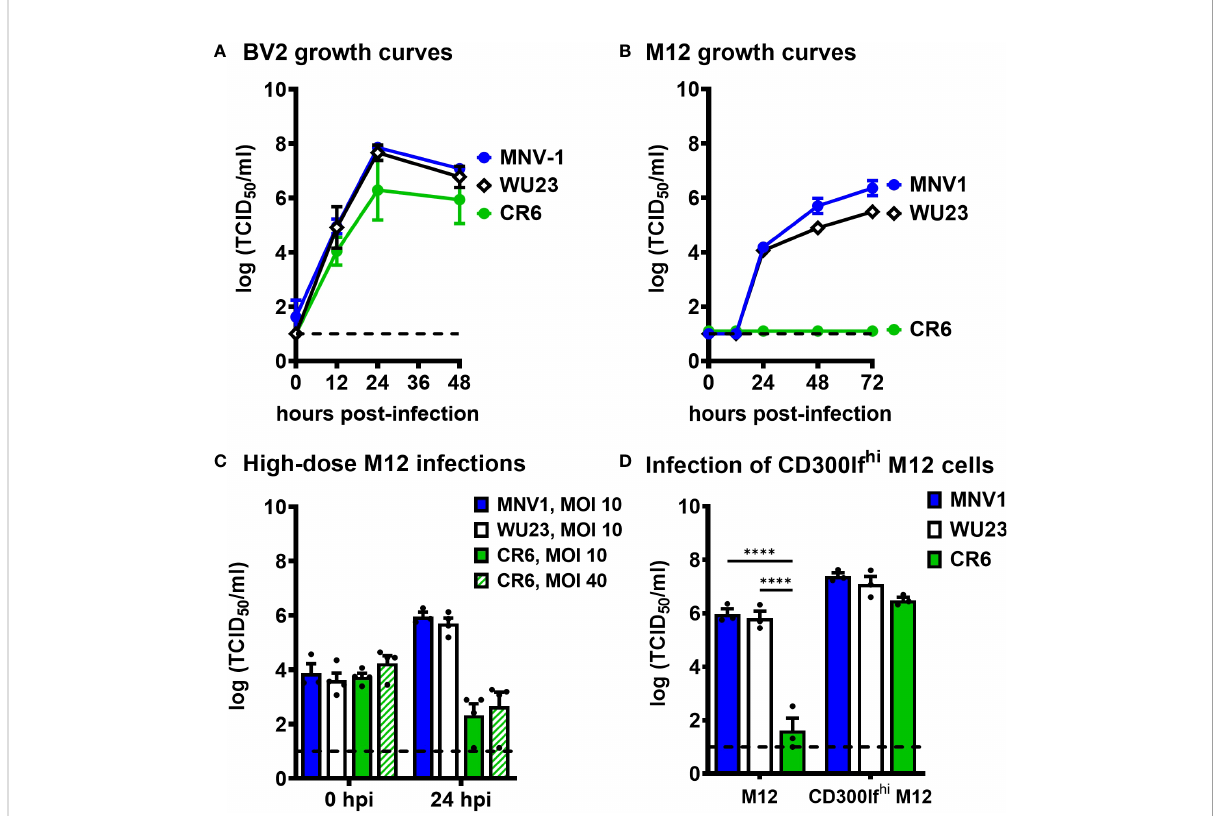
FIGURE 4 Diarrheagenic MNV1 and WU23 can infect CD300lf lo cells in vitro while attenuated CR6 cannot. (A, B) Duplicate wells of BV2 cells (A) or M12 cells (B) were infected with MNV1, CR6, or WU23 at MOI 0.05. Virus titers were determined by TCID 50 assay at the indicated timepoints on culture supernatants. P values were determined by ANOVA using Tukey ’ s multiple comparisons test. (C) Duplicate wells of M12 cells were infected with MNV1, CR6, or WU23 at MOI 10 or MOI 40 as indicated. Virus titers were determined by TCID 50 assay at the indicated timepoints. (D) CD300lf was overexpressed in M12 cells by lentivirus transduction. Duplicate wells of M12 cells or CD300lf-overexpressing M12 cells were infected with MNV1, CR6, or WU23, at MOI 5. Virus titers were determined by TCID 50 assay at 1 dpi. P values were determined using ANOVA with Sidak ’ s multiple comparisons test. At least three independent experiments were performed for all experiments. ****P <